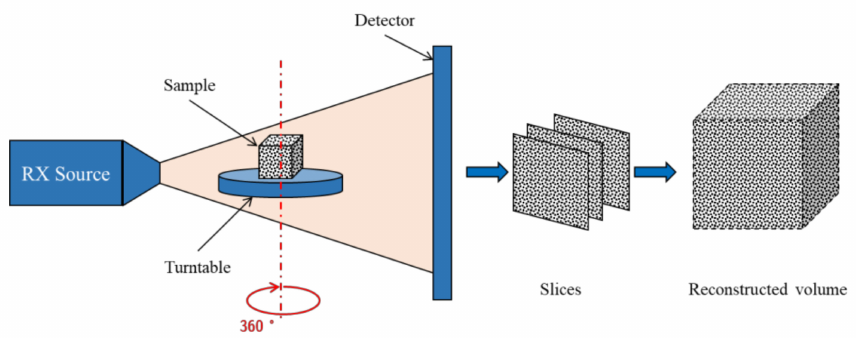
Figure 4. X-ray tomography